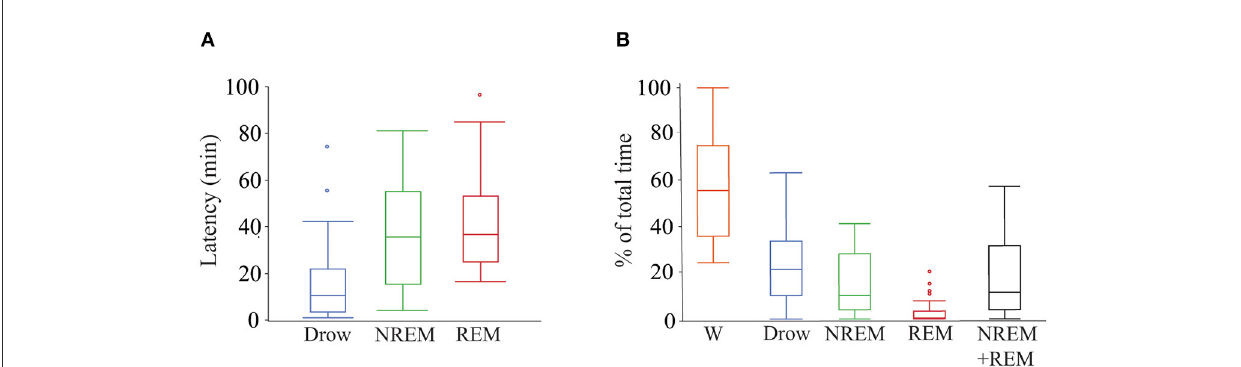
FIGURE2 Latency to and percentage of time spent in each behavioral state during polysomnography recordings. (A) Box plots showing latency in minutes to drowsiness, NREM and REM sleep. Only data from dogs that entered each specific behavioral state was employed (drowsiness n = 26, NREM sleep n = 24, and REM sleep n = 15). (B) Box plots showing percentage of total time spent in each behavioral state and the sleep efficiency (sum of time in NREM and REM sleep over total time). All dogs ( n = 28) were used. Box plots represent the median (central line of the box), the 25 and 75th percentile (lower and upper line of the box). The whiskers represent 1.5 times the interquartile range (1.5 * IQR) and outliers are shown with a circle. W, wakefulness; Drow, drowsiness; NREM + REM, sleep